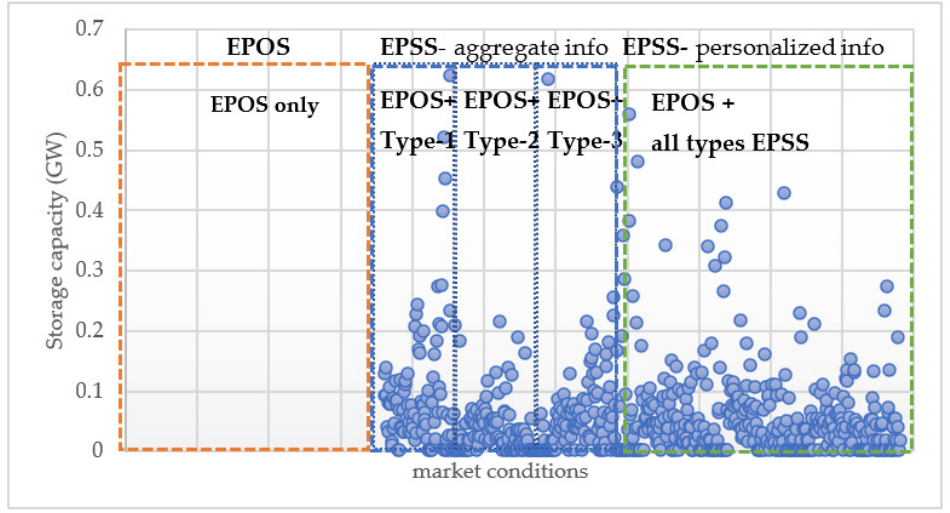
Figure 3. Market condition effect on storage capacity. (Data can be found in the Supplementary Materials).